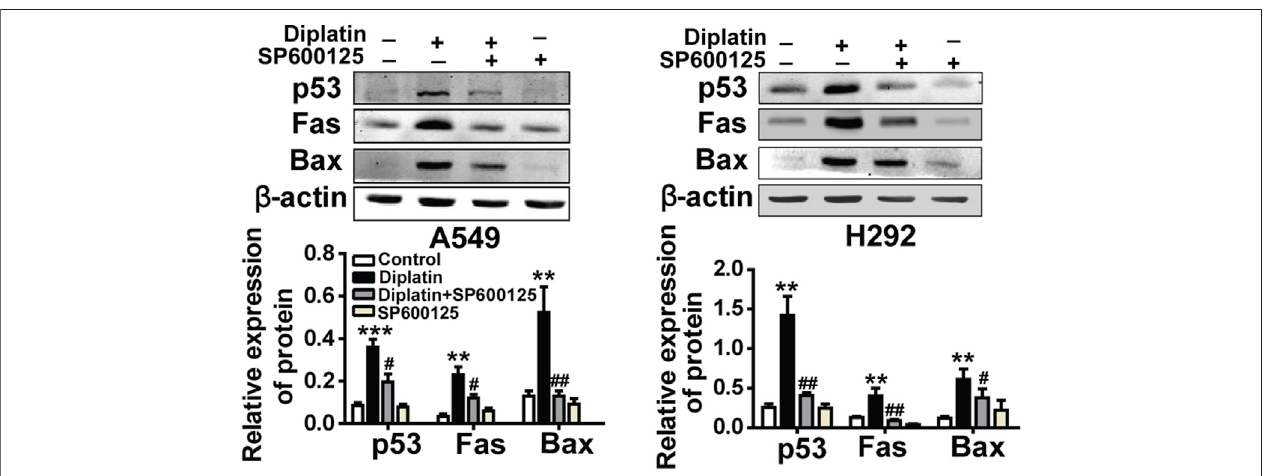
FIGURE 3 | JNK/p53-mediated pathway is involved in diplatin-induced apoptosis of tumor cells. (H) Pretreatment (0.5 h) with 10 μ M JNK inhibitor (SP600125) suppresses the 48 h time point 25 μ M diplatin-induced p53, Fas, and Bax protein upregulation ( n = 4 per group). The data are presented as mean ± SEM from three independent experiments, one-way ANOVA followed by the Student-Newman-Keuls test. Statistical signi fi cance is indicated by * p < 0.05, ** p < 0.01, and *** p < 0.001 for comparison with control and # p < 0.05, ## p < 0.01 for comparison with the diplatin-treated group.